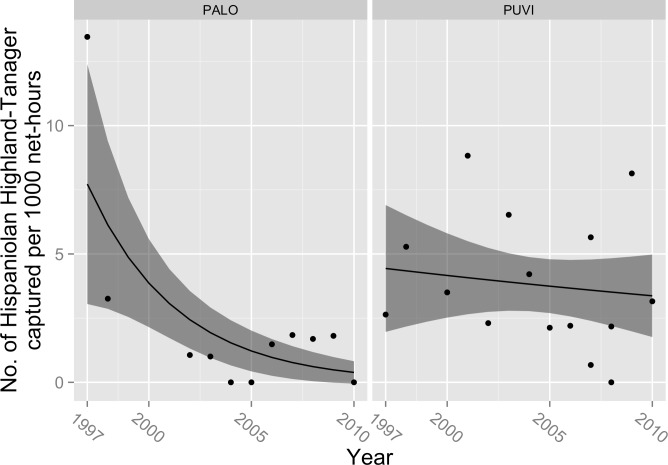
Trends in capture rate of Hispaniolan Highland-Tanager (Xenolegia montana).Observed capture rate (dots) of Hispaniolan Highland-Tanager and changes in expected capture rate (solid line; shaded area = 95% confidence interval) per 1,000 net-hours at two sites (PALO, Palo de Agua; PUVI, Pueblo Viejo) in montane broadleaf forest of Sierra de Bahoruco, Dominican Republic.